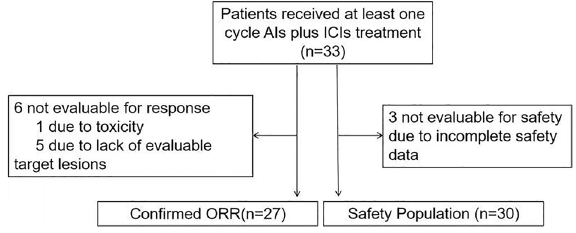
Figure 1. Study profile.